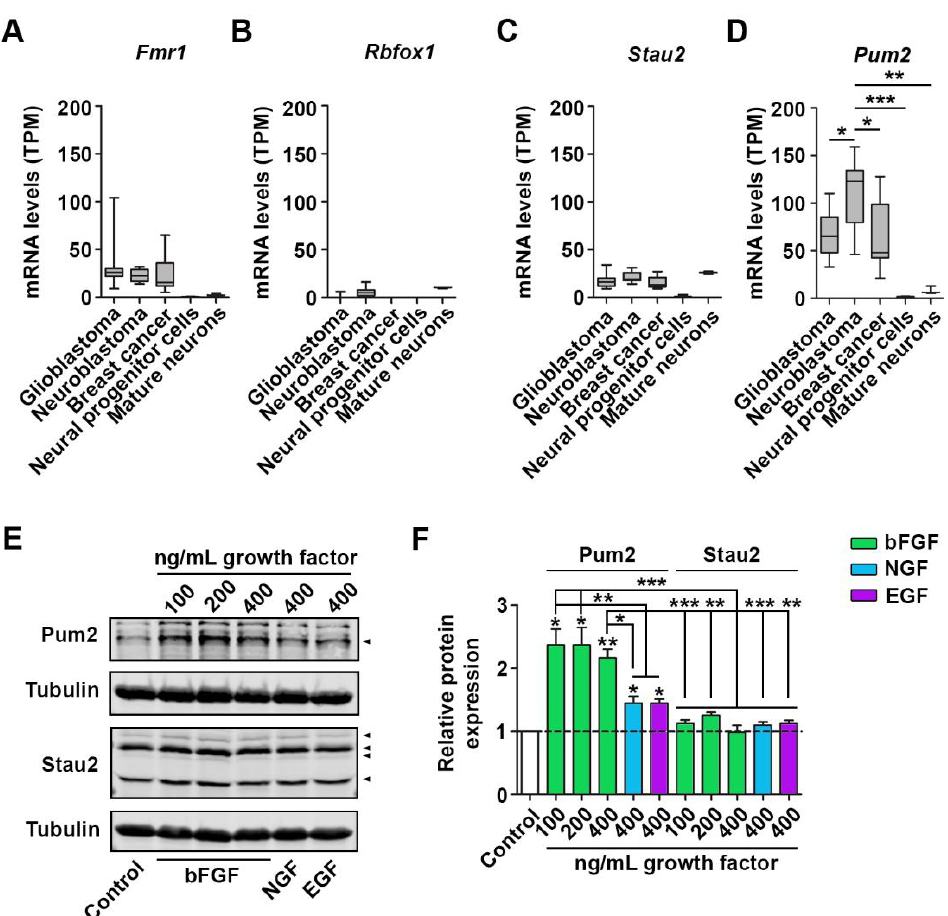
Figure 1 . Neuronal Pum2 expression is stimulated by bFGF. ( A – D ) mRNA levels as transcripts per million (TPM) of FMRP ( Fmr1 ) ( A ), Rbfox1 ( B ), Stau2 ( C ), and Pum2 ( D ) in different cancer cells as well as in healthy neural progenitor cells and mature neurons. ( E , F ) Representative immunoblots Pum2 and Stau2 € with respective quantifications ( F ) upon incubation of mature (14 DIV) cortical neurons with bFGF, NGF, and EGF, respectively, for two days. β -III-Tubulin was used as loading control. Arrow heads indicate the respective proteins. p -values were calculated using Kruskal–Wallis test with Dunn’s Multiple Compar ison Test ( D ), one-sample t- test within samples and Tukey’s Multiple Comparison Test between samples ( F ). * p < 0.05, ** p < 0.01, *** p < 0.001, 4 biological replicates.